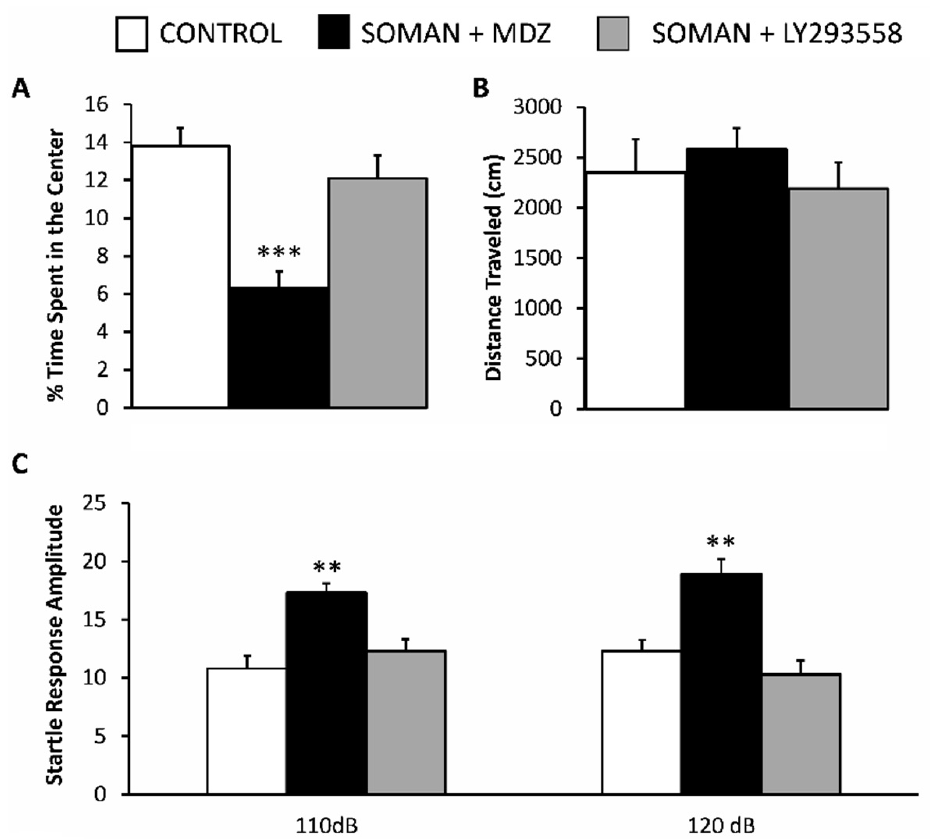
Figure 5. Thirty days after soman exposure, anxiety-like behavior was increased in the MDZ-treated group but not the LY293558-treated group. ( A ) Percentage of time spent in the center of the open field; ( B ) Distance traveled in the open field; ( C ) Amplitude of startle responses to 110- and 120-db acoustic stimuli. Sample sizes: n = 8 for each group. Control group is rats not exposed to soman. ** p < 0.01, *** p < 0.01 (One-Way ANOVA with Holm-Šídák post hoc test).